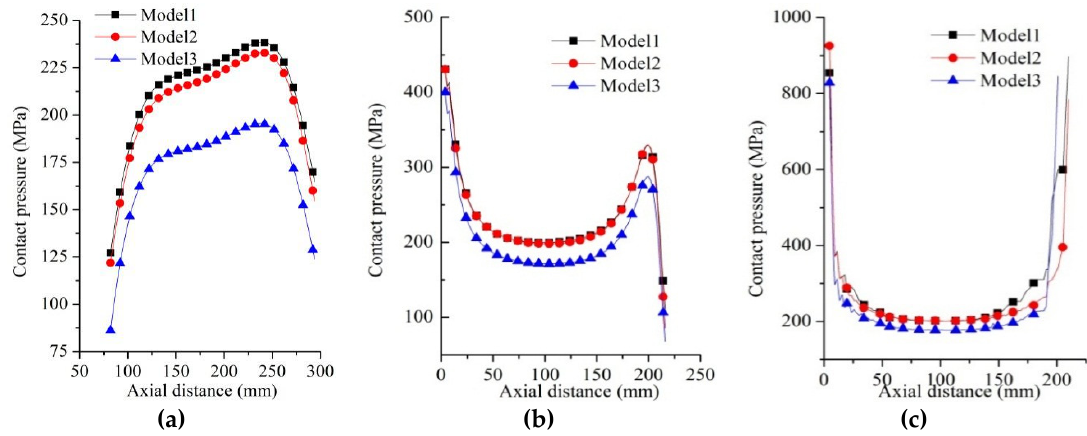
Figure 6. Distribution of contact pressure on each mating surface under different assembly clearances. ( a ) Mating surfaces of shaft and sleeve; ( b ) mating surfaces of sleeve and inner ring; ( c ) mating surfaces of inner ring and outer ring.